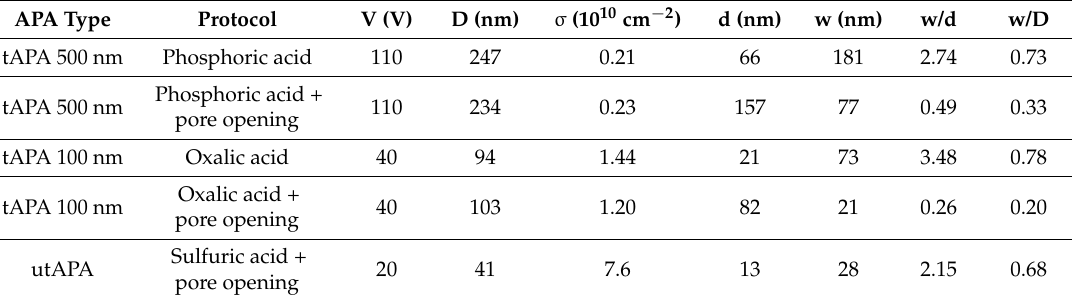
Table 1. Typical geometric figures of the fabricated utAPA vs. tAPA of 100 and 500